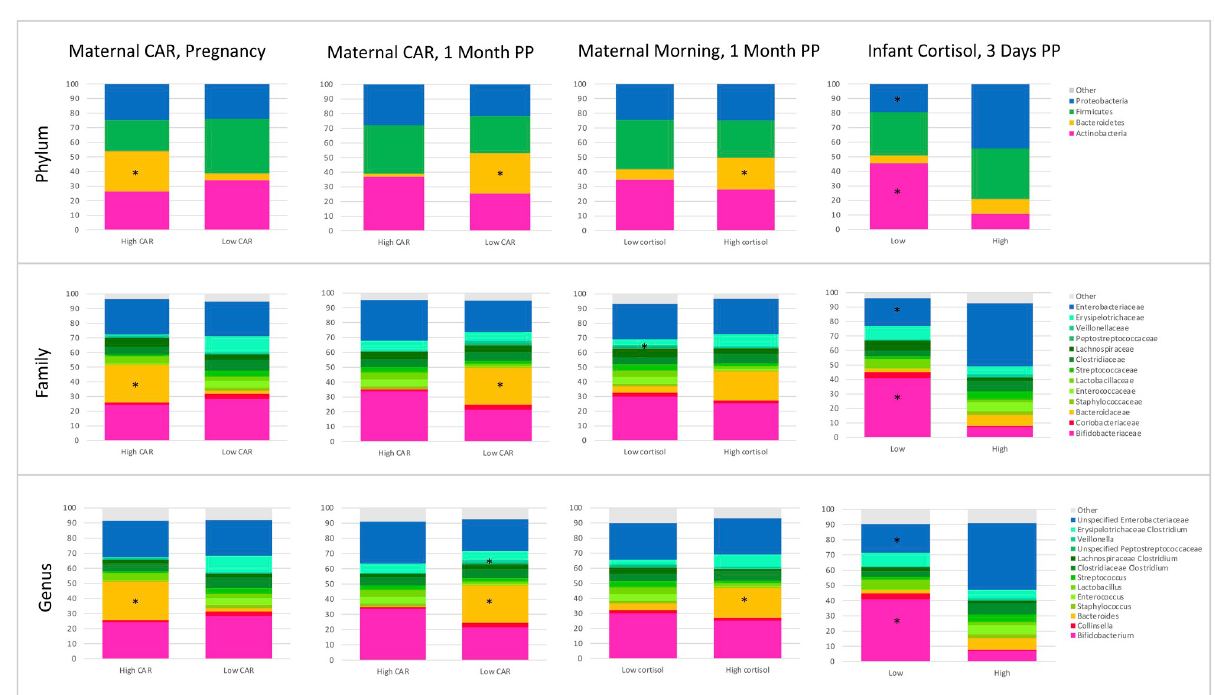
Fig 5. Maternal and infant cortisol are associated with differential relative abundance of the phylum, family, and genus taxonomic levels in infant stool. � Indicates p �